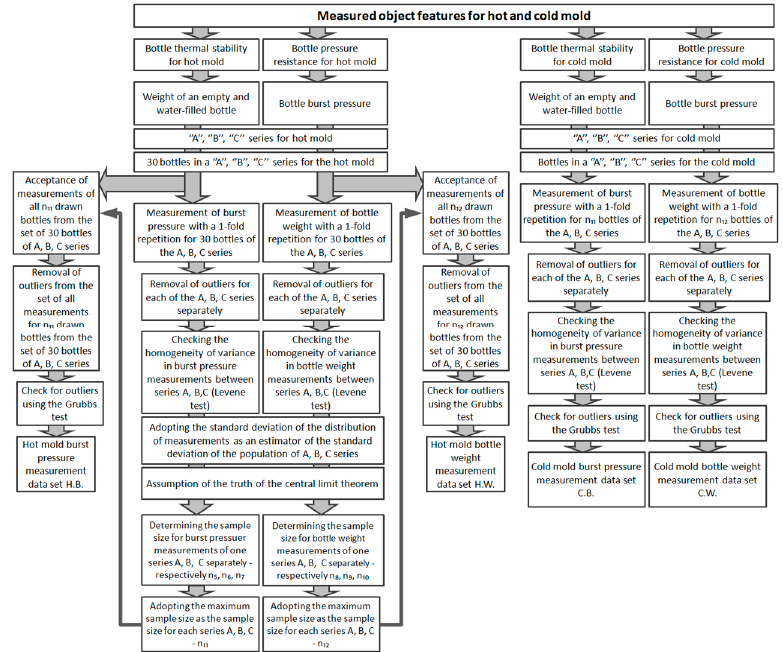
Figure A2. Method of statistical preparation of the measurement data set for pressure resistance (H.B.) and thermal stability (H.W.) of hot fill bottles as well as pressure resistance (C.B.) and thermal stability (C.W.) of cold fill bottles, respectively (the sample size was determined in accordance with Formula